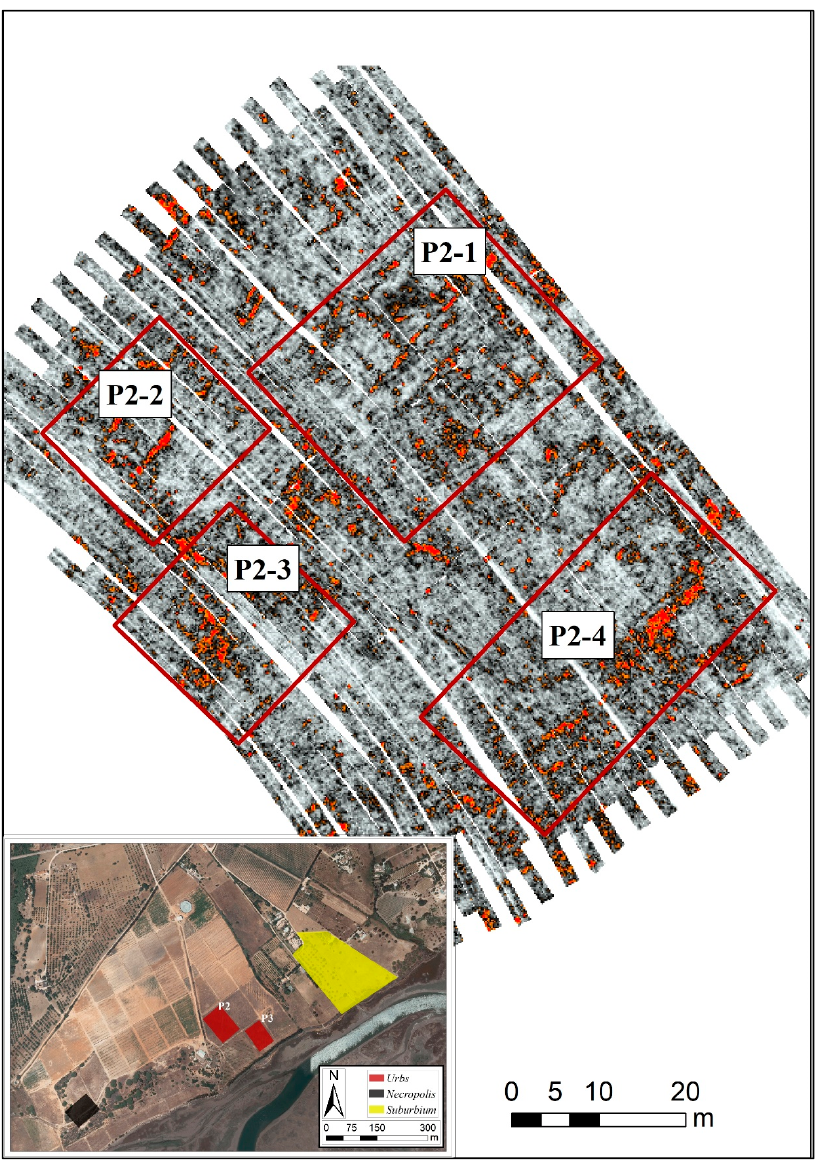
Figure 5. Groups of alterations in project 2.